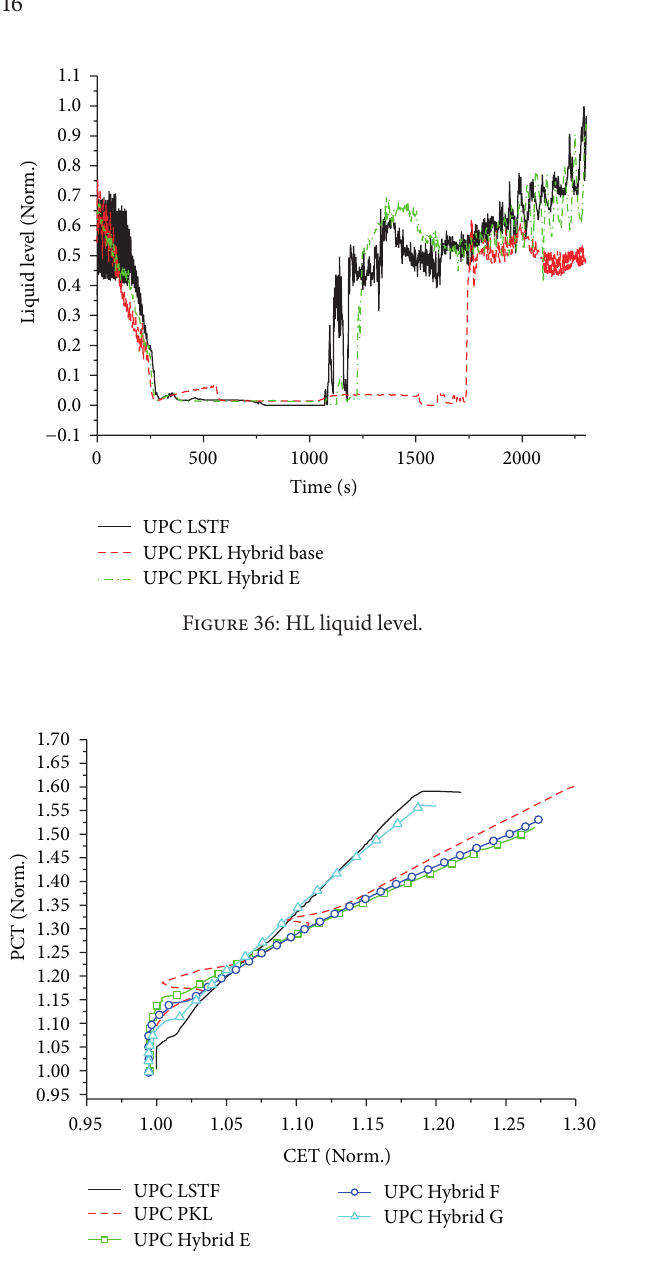
Figure 37: PCT versus CET curve.